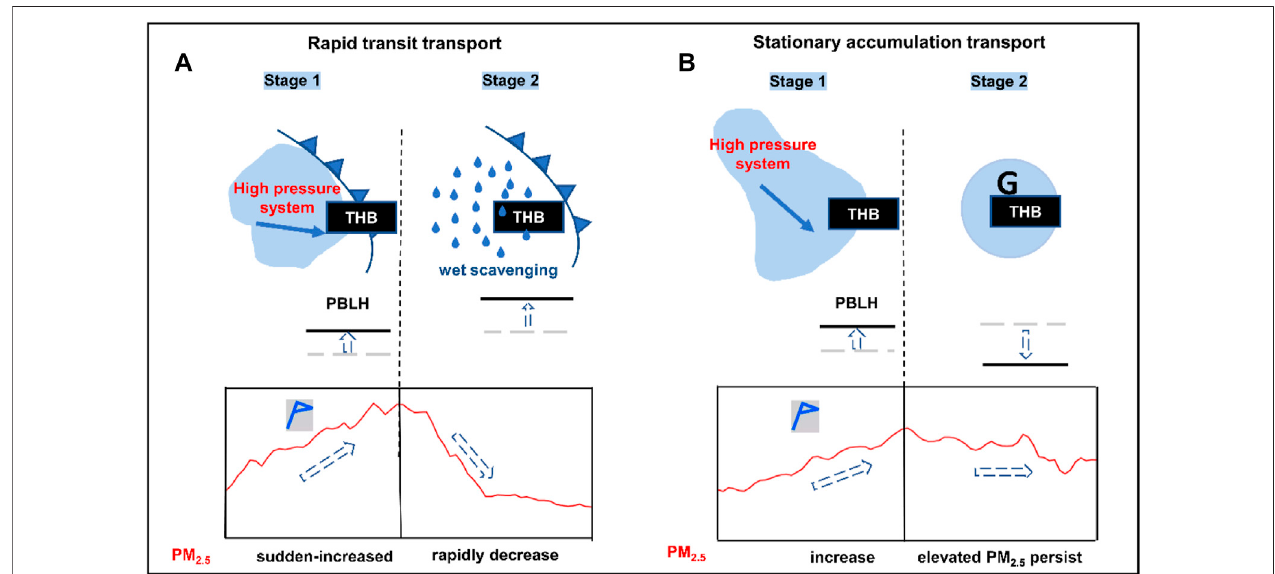
FIGURE 9 | Diagram of meteorological mechanism on regional PM 2.5 transport with the typical patterns of (A) RTT and (B) SAT driving the PM 2.5 concentration changes (bottom line graphs) for heavy air pollution over the THB revealed in this study.